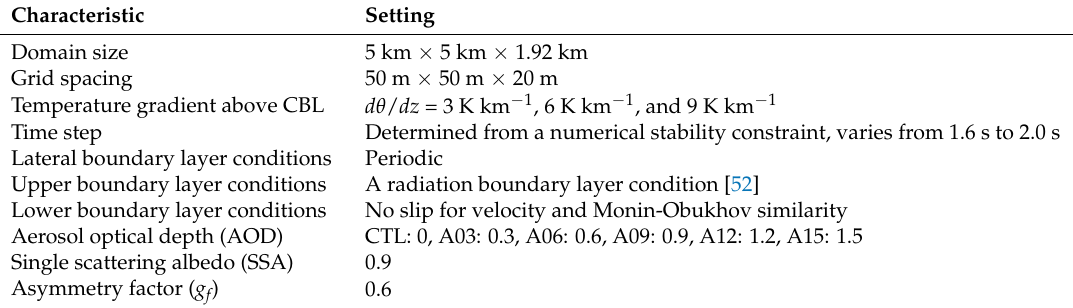
Figure 1. Initial vertical profile of potential temperature. The potential temperature gradient in free atmosphere ( d θ / dz ) varies from 3 K km − 1 to 9 K km − 1 . θ : potential temperature; z: height above the ground . Table 1. Settings of large-eddy simulation (LES) experiments. CBL: convective boundary layer. d θ / dz: the potential temperature gradient in free atmosphere. CTL: control case with AOD = 0. A03: aerosol case with AOD = 0.3, and similarly for the others.